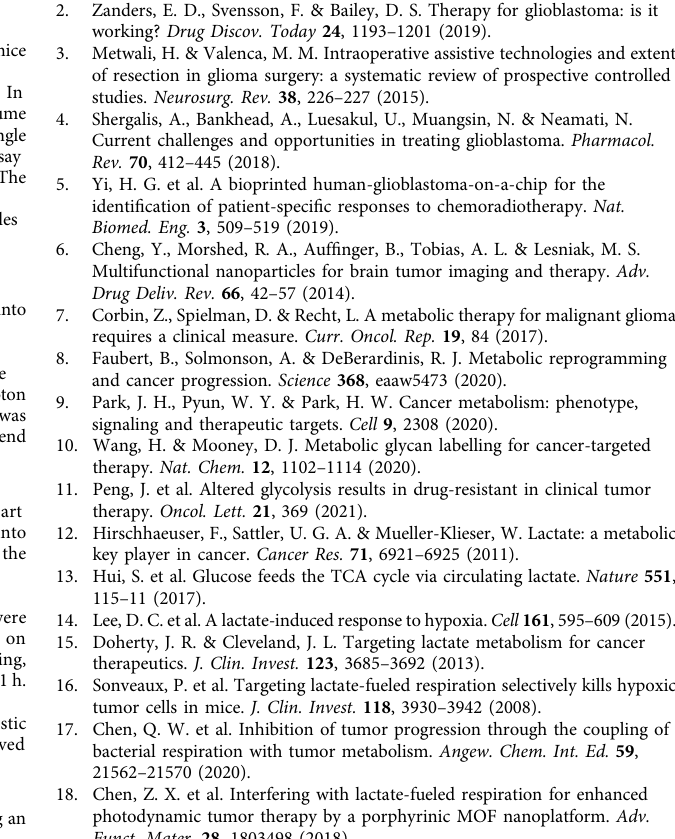
Figshare (https://doi.org/10.6084/m9. fi gshare.19825075.v1). Source data for the fi gures in the Supplementary Information are available at Figshare (https://doi.org/10.6084/m9. fi gshare.19825096.v1). The RNA-seq has been deposited to NCBI under accession codes PRJNA747130. The mass spectrometry proteomics data has been deposited to